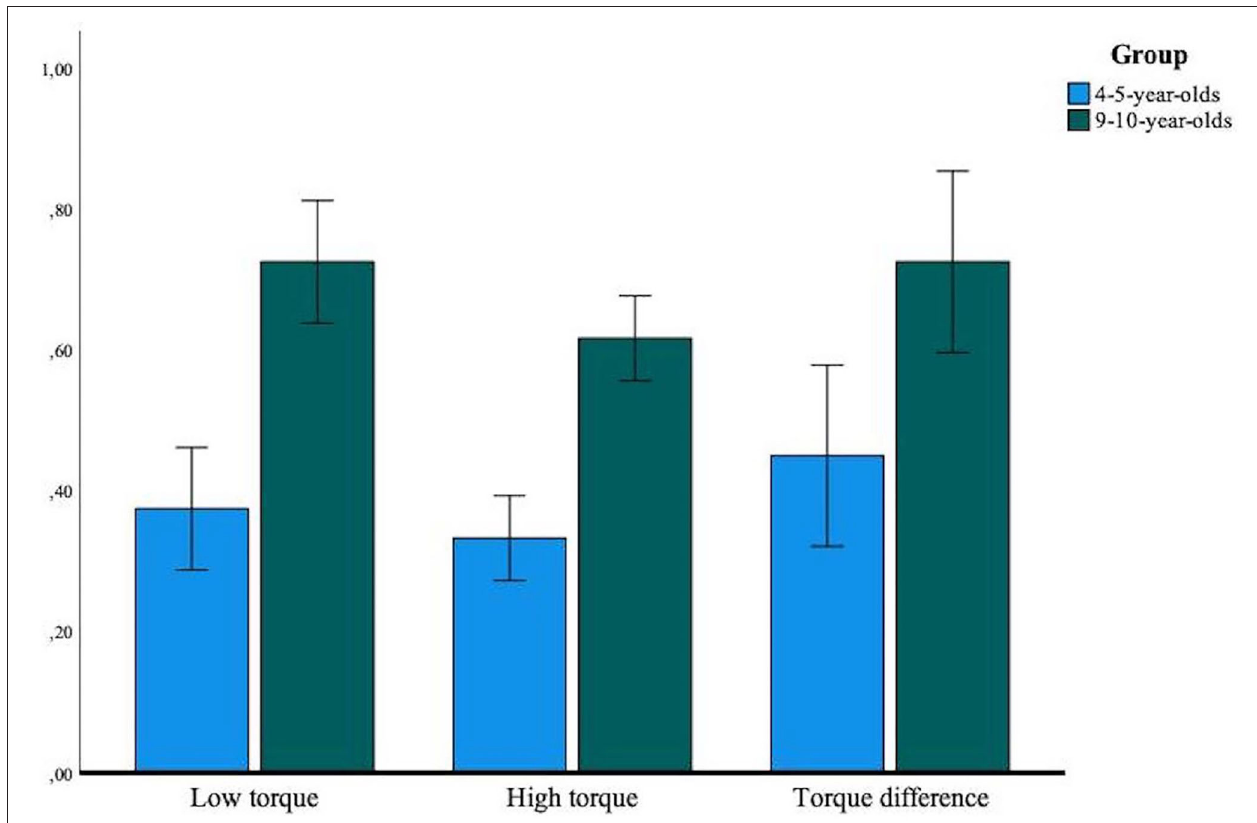
FIGURE 2 | Mean group success rate by torque type. Error bars represent the 95% confidence